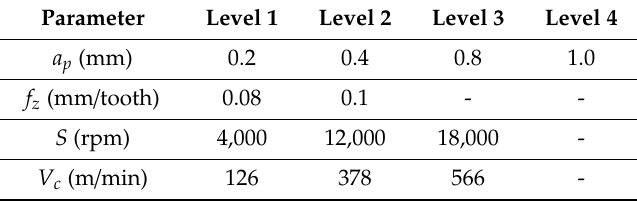
Table 1. Machining parameters and levels for skin sample